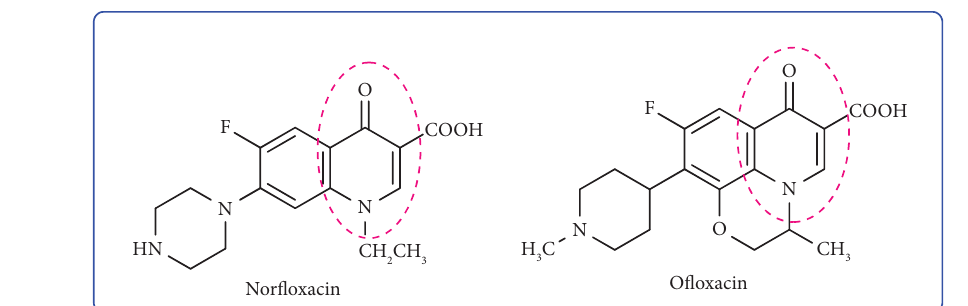
Figure 2: Structure of piperidinone pharmacologically active